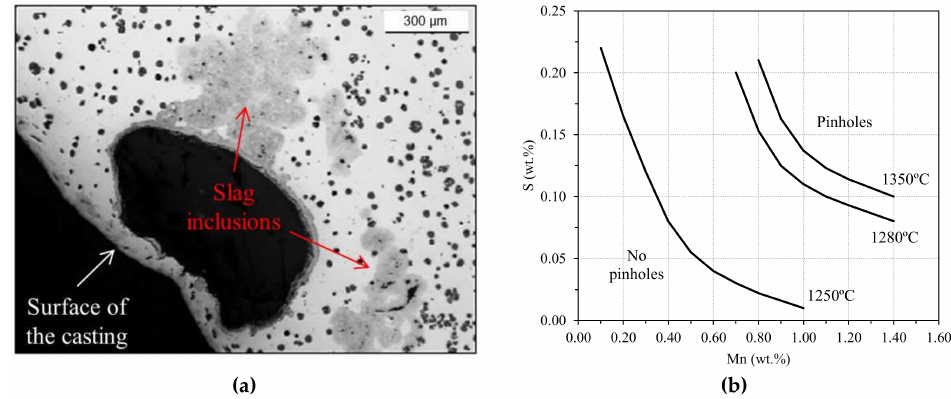
Figure 9. ( a ) Example of a carbon monoxide-related pinhole, which is deformed after shot blasting the surface of the casting; ( b ) evaluation of the pinholes’ formation according to sulfur and manganese contents in the melt (grey cast irons) at different temperatures. (Adapted with permission from ref. [12]. Copyright 1994